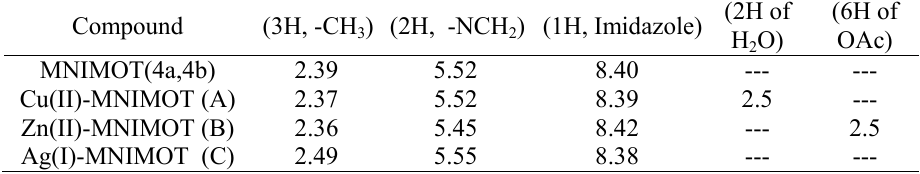
Table 5. 1 H NMR Spectra of ligand (MNIMOT) and its metal